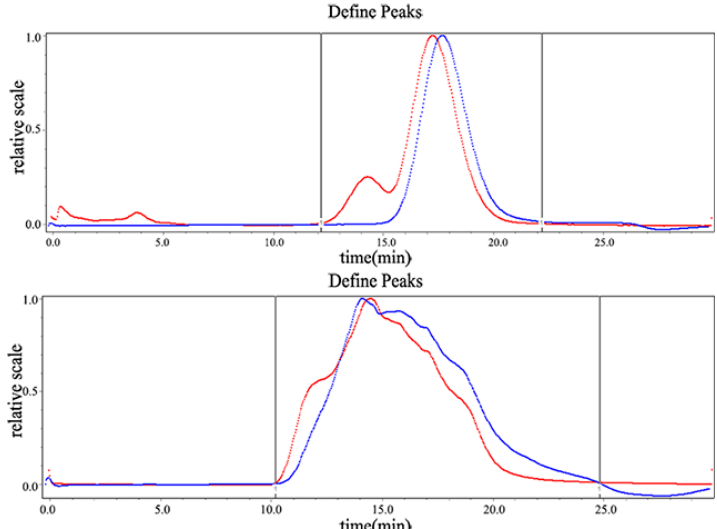
Figure 2. The molecular weight determination spectrum of pumpkin polysaccharides by HPGPC after the calibration of the dextran standard. The upper panel shows the dextran control, and the lower panel shows the pumpkin polysaccharides. The red lines represent the detection results of the 18-angle laser light scatterer, and the blue lines represent the detection results of the differential refractive index detector. The curve is the molecular weight distribution curve of the computer’s automatic statistics.